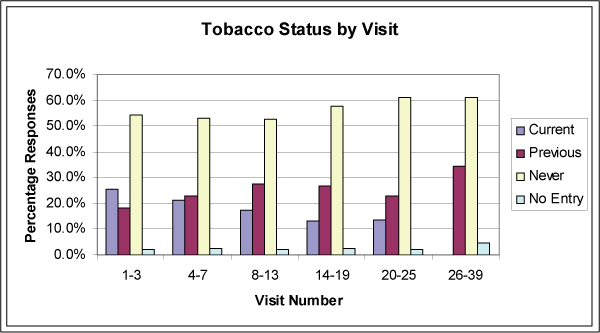
Tobacco use status aggregates by visit number.